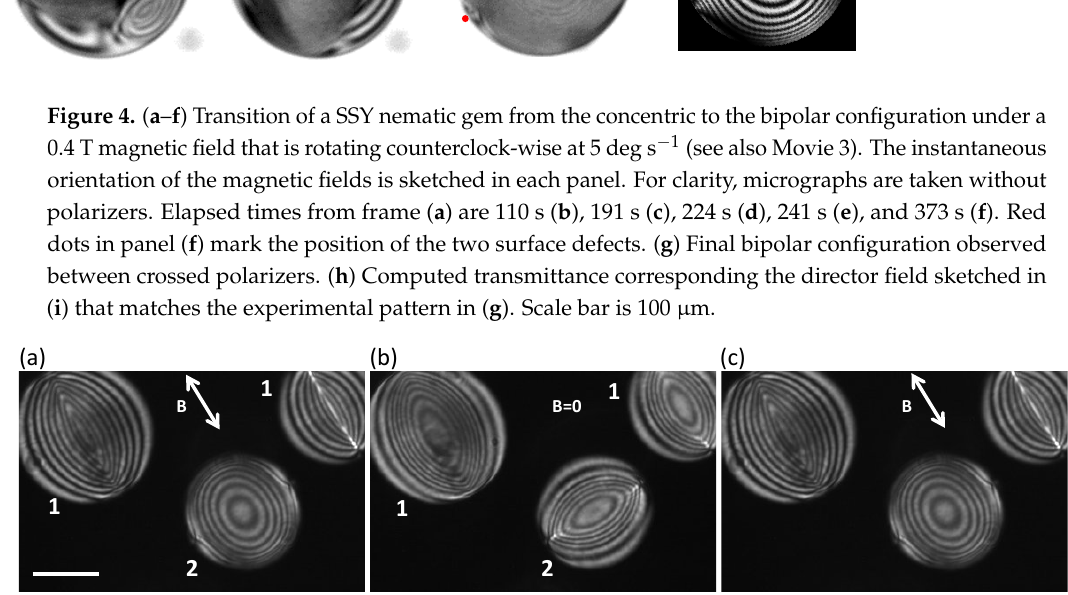
Figure 5. ( a ) Concentric (1) and bipolar (2) SSY nematic gems coexisting under a static 0.4 T magnetic field that had been previously rotated at 5 deg s − 1 . ( b ) The magnetic field is removed, leading to twisted bipolar configurations, with the two types of gems observed in ( a ) oriented orthogonaly to each other. ( c ) Upon quick re-application of the 0.4 T field, the same original textures obtained in ( a ) are recovered, illustrating a memory of the bipolar texture. Scale bar is 50 µ